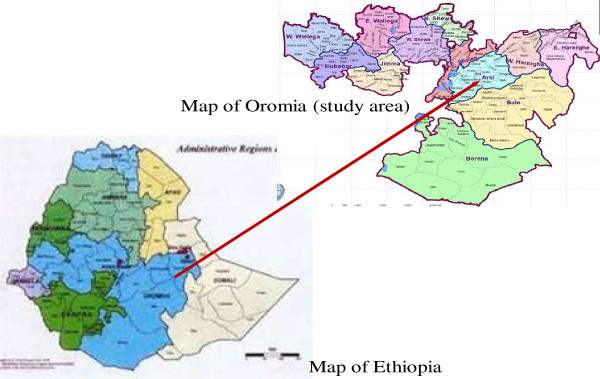
Location of study site.